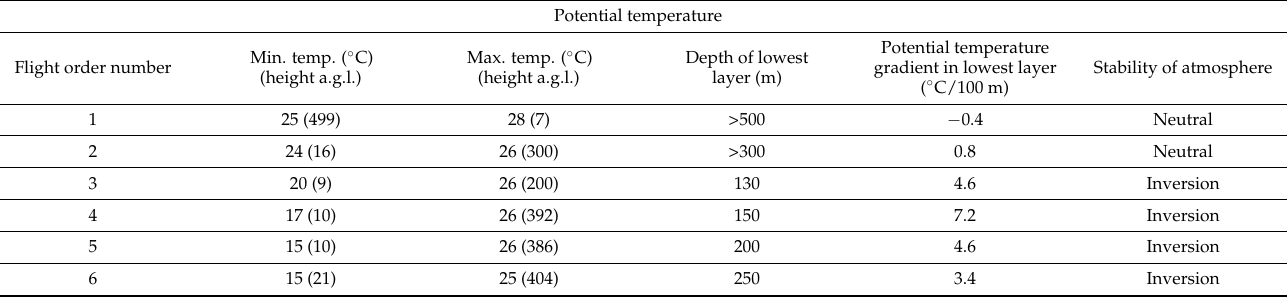
Table A2. Stability of atmosphere on 18 September